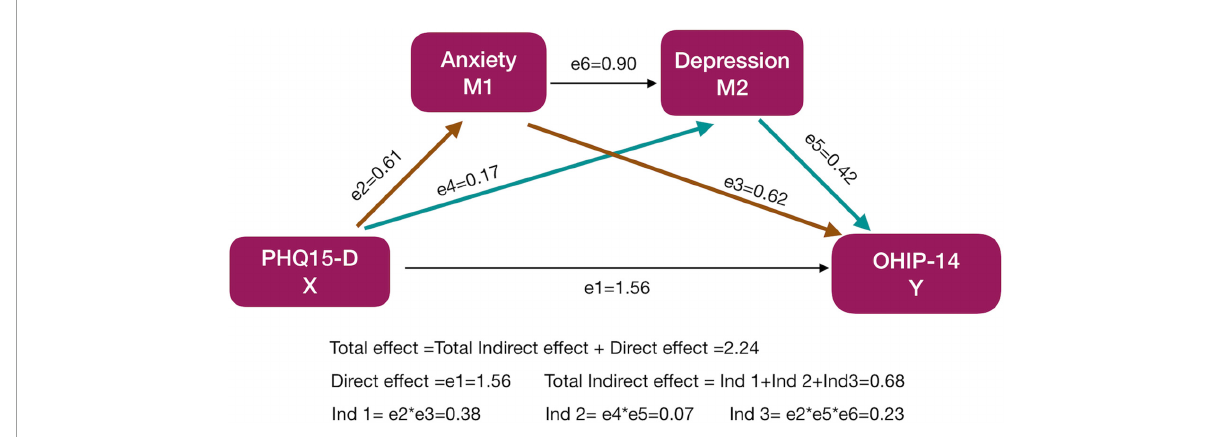
FIGURE1 The schematic diagram of the chain intermediary analysis model. The influence of anxiety and depression on the relationship between digestive conditions and alcohol was evaluated. Regression analysis was performed for every two variables to obtain different effect coefficients (e1, e2, e3, ... ), and the indirect effect coefficient values were further calculated for the different pathways. Different colours were used to better display the equations. The yellow arrows (e2, e3) were effect coefficients included in Ind 1, the green arrows (e4, e5) in Ind